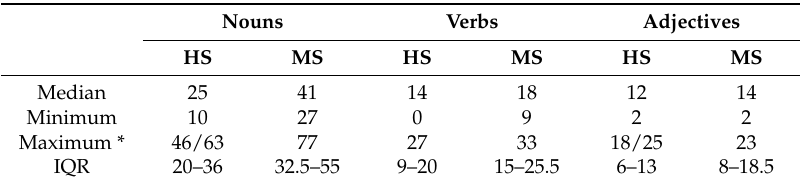
Table 1. Lexical distribution and variation per group of European Portuguese (EP) speakers regarding the